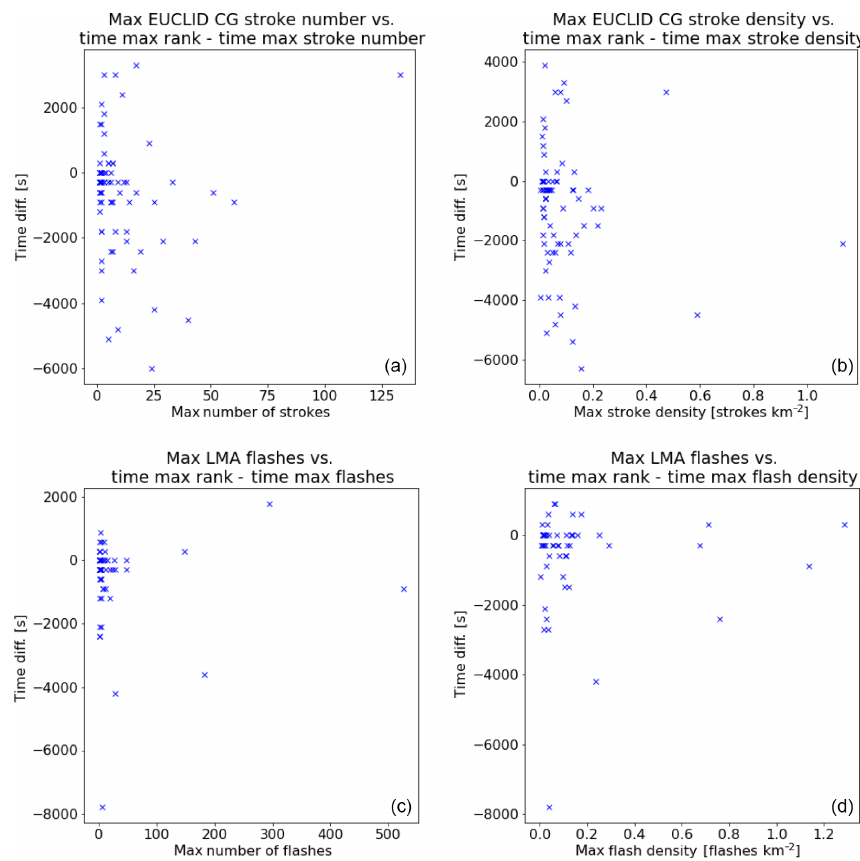
Figure 6. Scatter plot of (a) maximum number of CG strokes detected by the EUCLID network with respect to time difference between occurrence of maximum rank and occurrence of maximum flashes. (b) Same as (a) , but for stroke density. (c) Same as (a) , but for LMA- detected flashes. (d) Same as (b) , but for LMA-detected